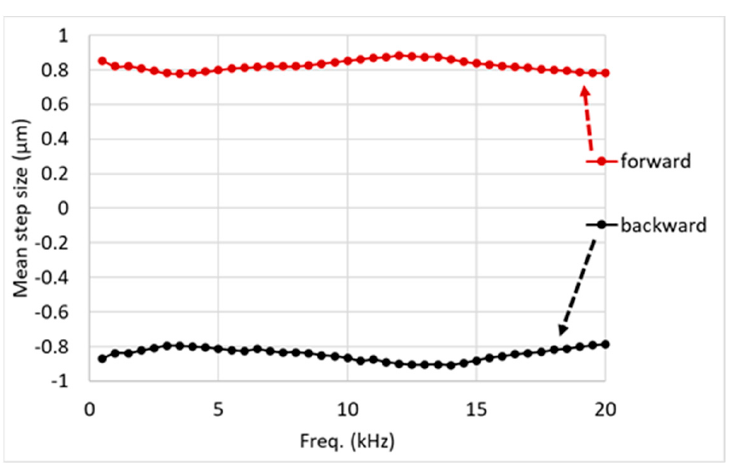
Figure 25. Open loop mean step size measurements when the motor was operated in forward and backward directions at frequencies ranging from 0.5 kHz to 20 kHz.